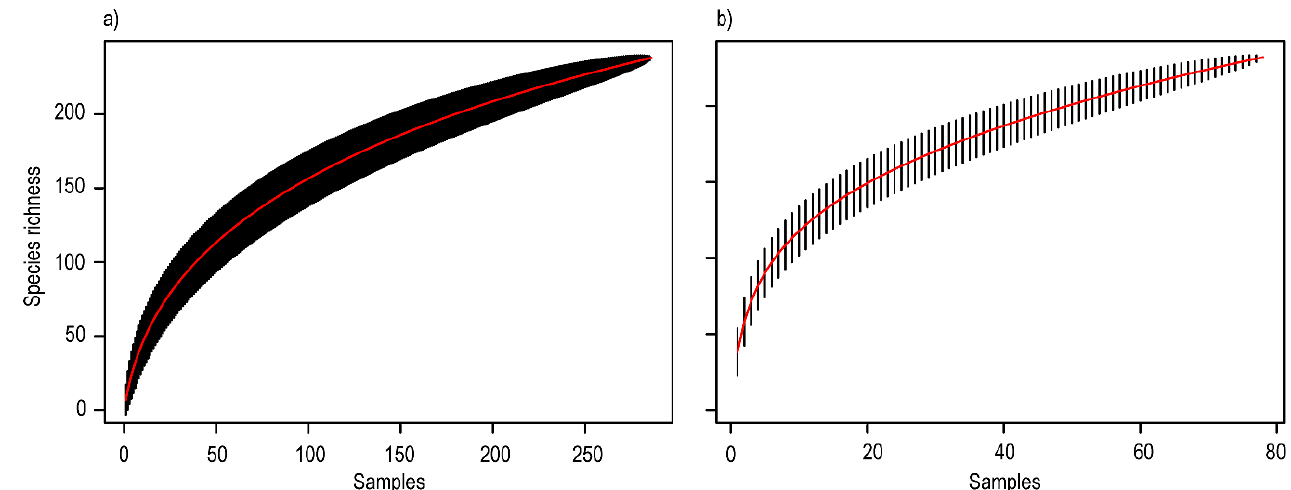
Figure 2. Species accumulation curves for post-larval ( a ) and juvenile fishes ( b ). One sample corresponds to the catch of each light trap per night ( a ) or each mosquito seine net per day ( b ). With black bars: interval of confidence and Red line: accumulation curve.